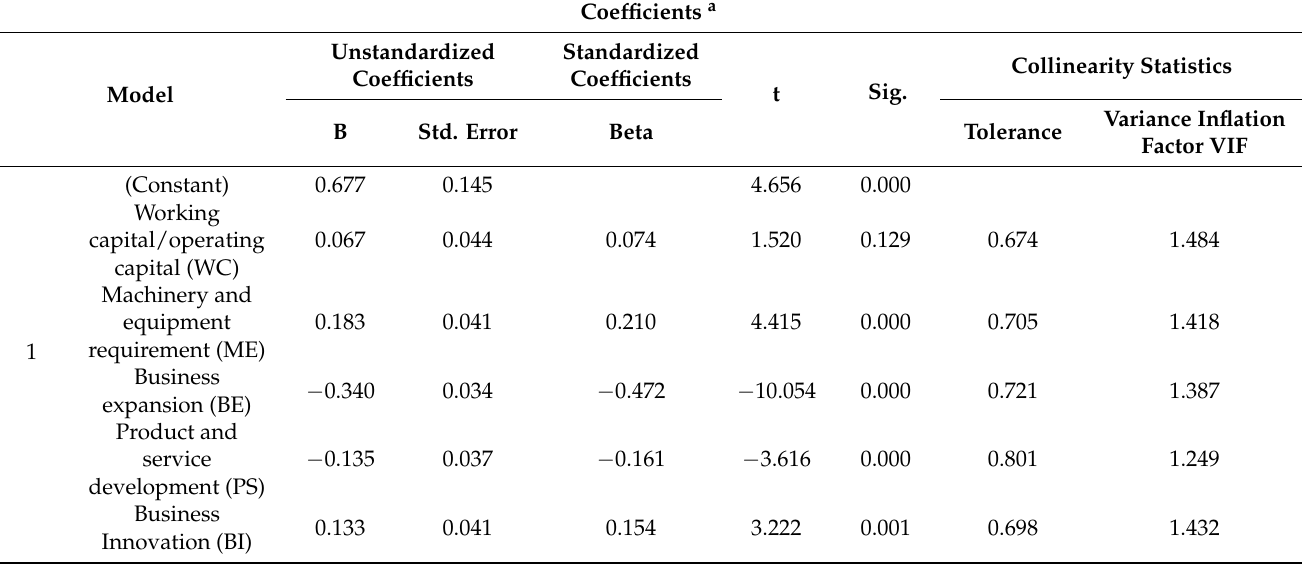
Table 4. Test of multicollinearity for